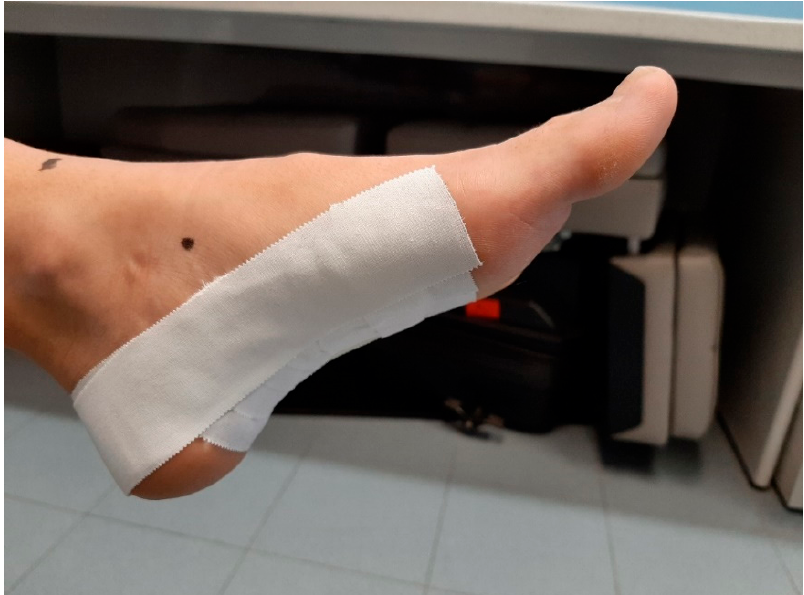
Figure 4. Low-Dye tape.